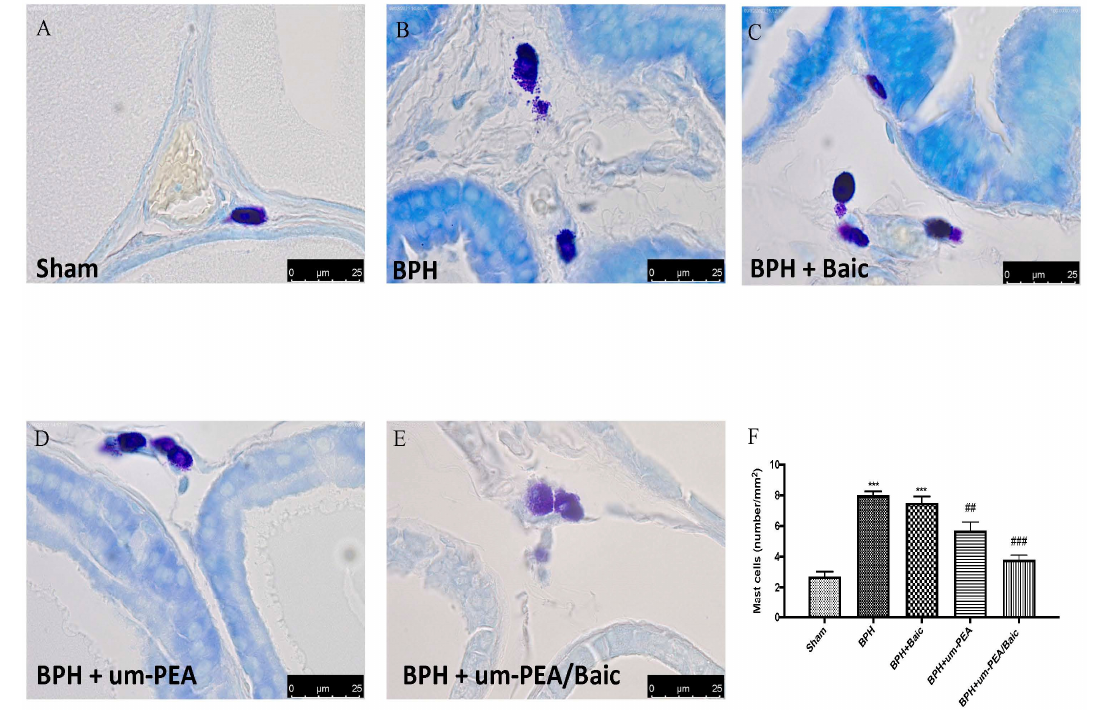
Figure 4. Effect of um-PEA/Baic on mast cell density. Evaluation of mast cell degranulation by toluidine blue: sham ( A ); BPH ( B ); BPH + Baic ( C ); BPH + um-PEA ( D ); BPH + um-PEA/Baic ( E ); mast cell count ( F ). Images are indicative of at least 3 independent experiments. Values shown are means ± SEM of six animals in each group. A 100X magnification is shown (25- μ m scale bar). *** p < 0.001 vs. sham; ## p < 0.01 vs. BPH group; ### p < 0.001 vs. BPH group.